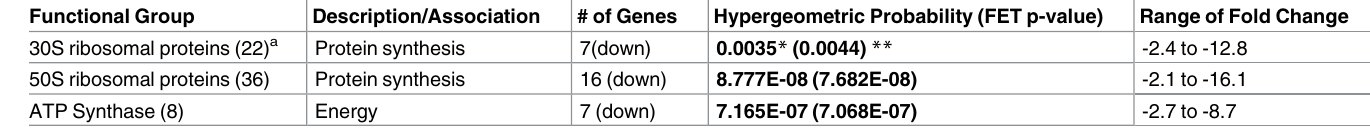
Table 2. Differentially expressedfunctional categories indicative of M . tb replication. Functional Group